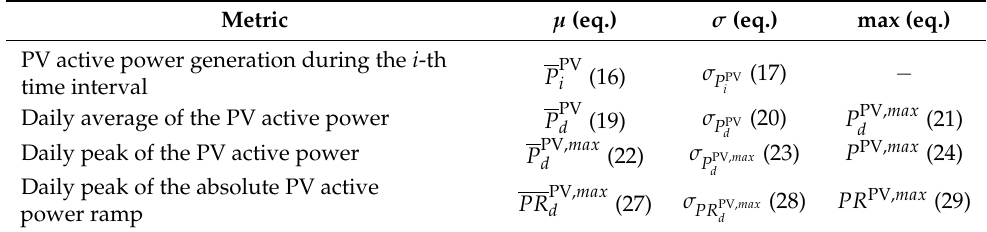
Table 2. Summary of the metrics and reference to the related equations adopted to analyze the PV profiles. µ : average value, σ : standard deviation, max: maximum